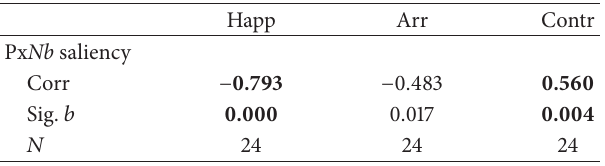
Table 5: Pixel saliency